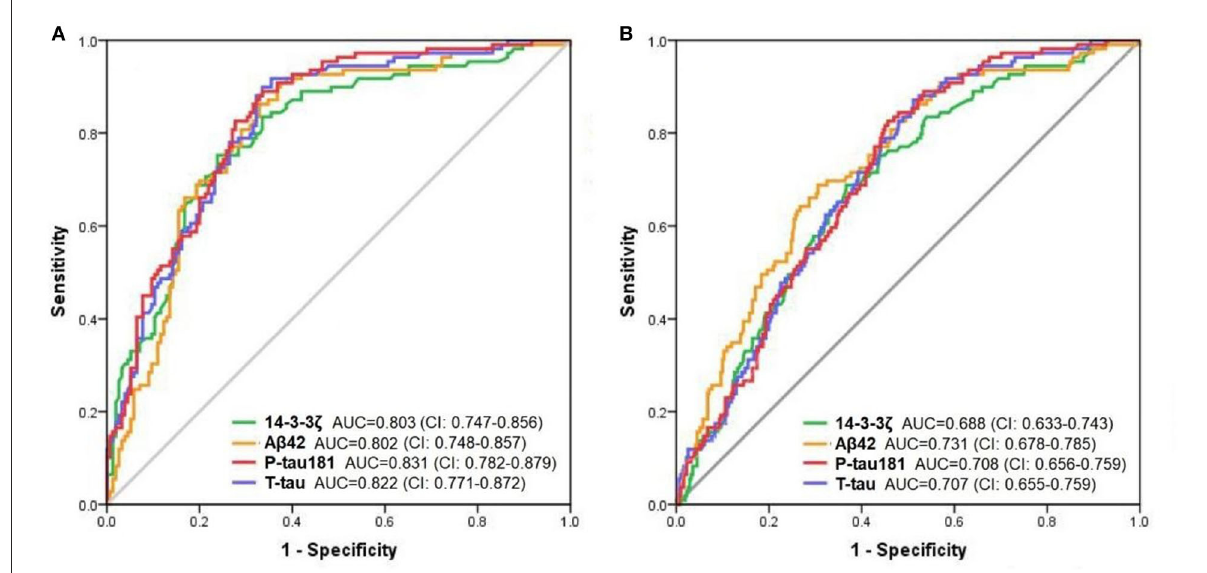
FIGURE2 The ROC analyses. The diagnostic utility of CSF biomarkers in differentiating AD from CN (A) and MCI (B) by ROC analyses.